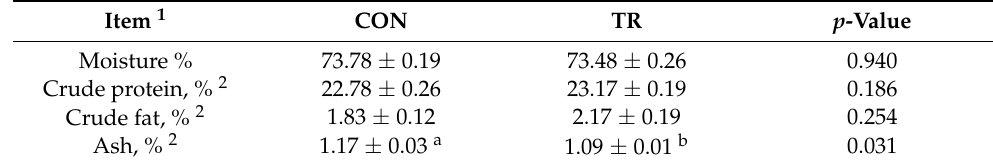
Table 2. Chemical characteristics of Longissumus dorsi muscle of Charolais beef cattle fed control diet (CON) and diet supplemented with omega-3 lipid supplement (TR).